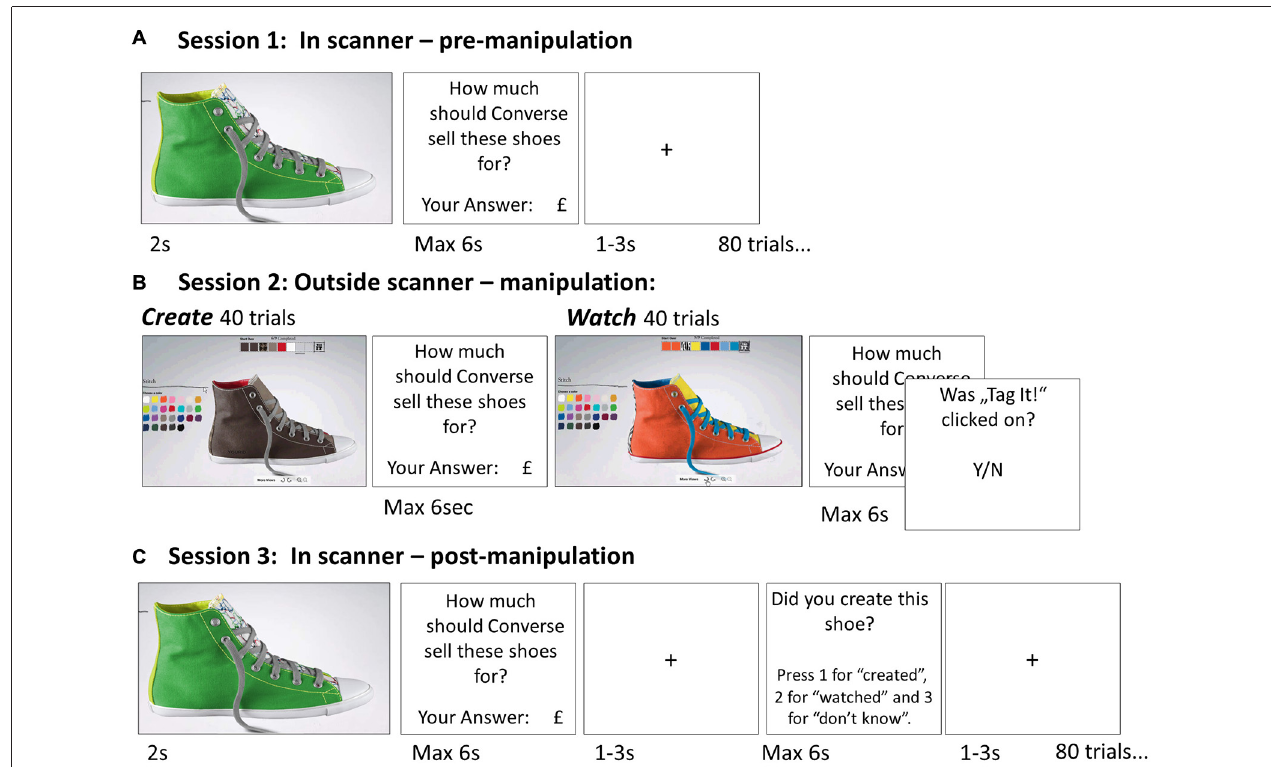
FIGURE 1 | Paradigm Experiment 1. (A) Session 1 (pre-manipulation) was conducted in the fMRI scanner. On each of the 80 trials participants were presented with an image of a different Converse shoe and asked to key in their suggested retail price for that shoe using a button box. (B) Session 2 (manipulation session) was performed on a computer outside the scanner. There were 40 create trials interleaved with 40 watch trials. On each create trial participants were given specific instructions for creating one of the shoes presented in Session 1 (i.e., no customization allowed). The instructions were given as a series of colors and patterns that indicated which color/pattern was to be chosen for each part of the shoe (there were nine parts including laces, outer body, heel, etc.). The participants created the shoe on the Converse website (they were trained on creating shoes before they began) and clicked “save” when they were finished. On watch trials they viewed a video that portrayed the shoe being created on the website. To make sure they attended, at the end of each watch trial they indicated whether a “tag” button was clicked on the video. (C) Session 3 (post manipulation) was identical to Session 1, except that participants were also asked to indicate if they created the shoe in the previous session, watched it being created, or did not